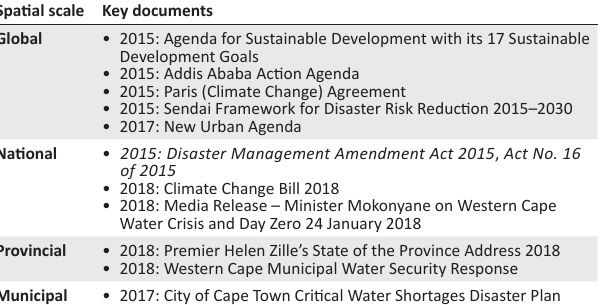
TABLE 1: Key documents retrieved for Day Zero information and